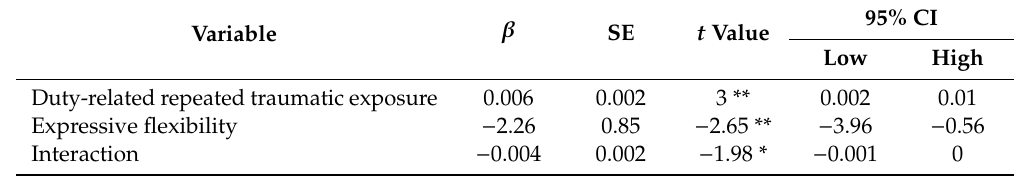
Table 2. Estimated coe ffi cients, standard errors, and 95% confidence intervals for independent variable and moderator in the model predicting PTSD